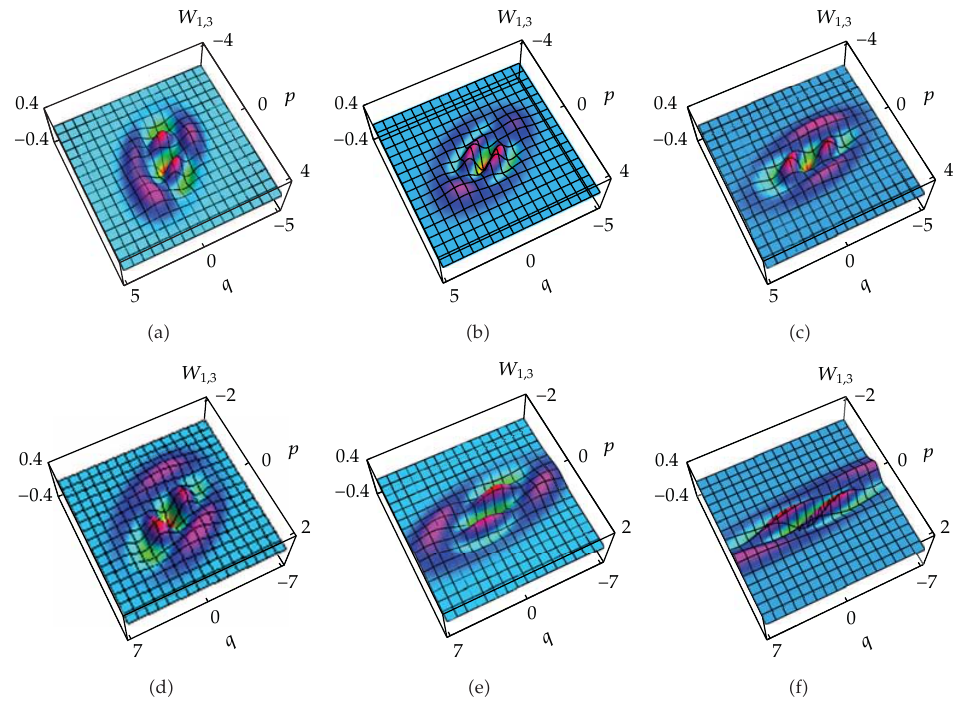
√ 2 (cid:5)(cid:4) | 1 (cid:4) (cid:9) | 3 (cid:4) (cid:5) at successive times; δ 0 (cid:8) 0 .